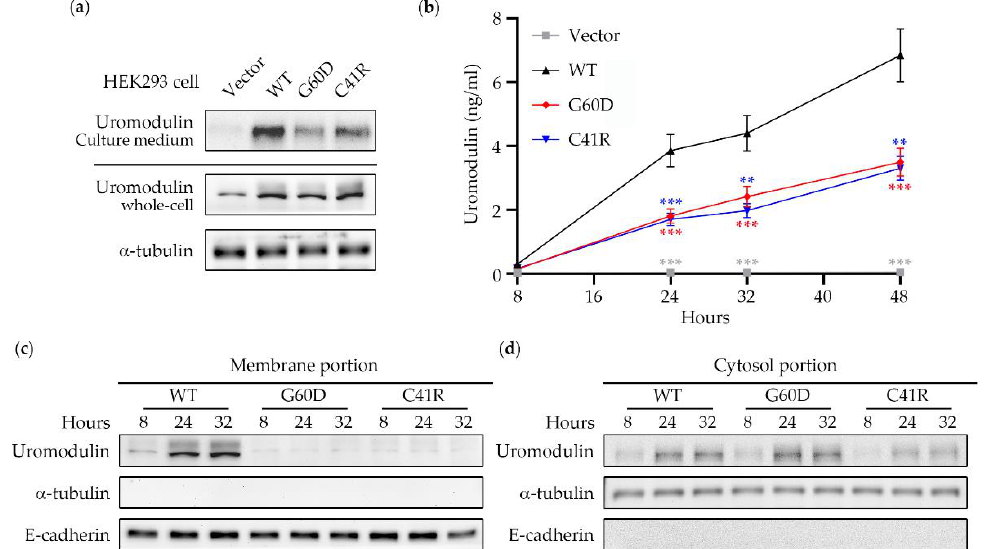
Figure 3. Uromodulin expression profile in transient-transfected HEK293 cells. ( a ) After 24 h of transient transfection with an equal number of HEK293 cells, a similar amount of uromodulin protein could be identified in the whole-cell lysates of WT and mutant-transfected cells. The uromodulin portion condensed from the culture medium was higher in WT compared to the other two groups. ( b ) Wildtype transfected cells had a higher uromodulin content in the culture medium (6 ng/mL at 48 h) compared with the two mutants (3 ng/mL at 48 h). The statistic results were presented as ** ( p < 0.01) and *** ( p < 0.001). ( c ) Membrane portions and ( d ) cytosol portions of WT, G60D, and C41R transfected cells were collected after 24hr after transient transfection. The western blot showed that WT uromodulin had influential bands around 100kDa, and only faint signals were detected in the G60D and C41R uromodulin membrane portions. In contrast, uromodulin gradually increased over time and showed a similar expression pattern among the three groups. E-cadherin is represented as a membrane marker, while a-tubulin is a cytosol marker. WT: wildtype; G60D: p.Gly60Asp; C41R: p.Cys41Arg.